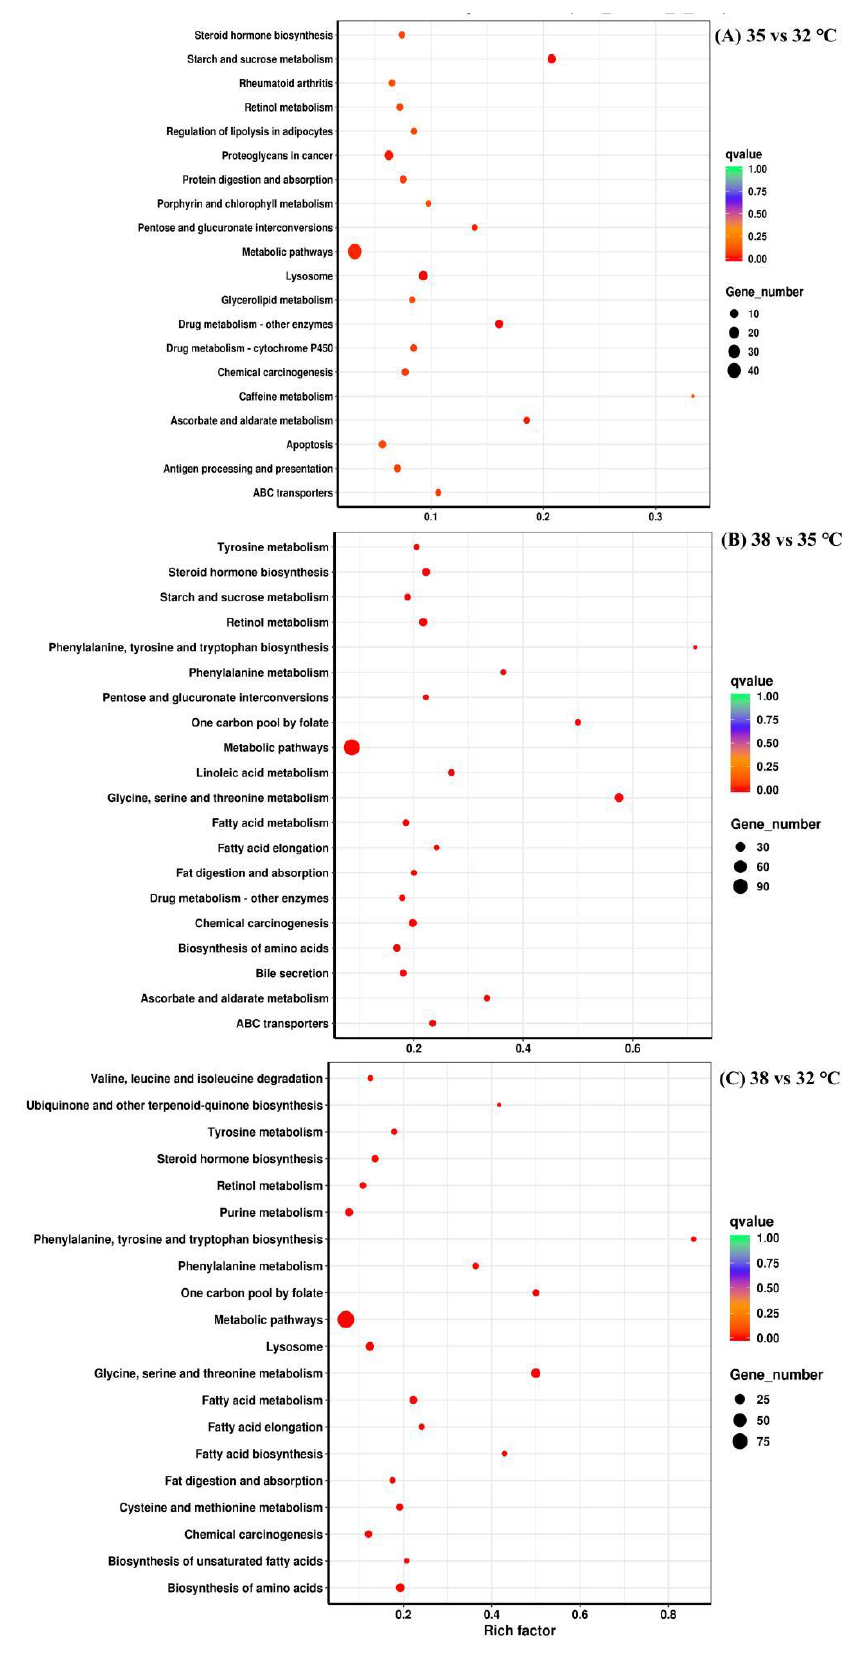
Figure 4. KEGG enrichment analysis of adult P. quatuordecimpunctata under different temperature stress.